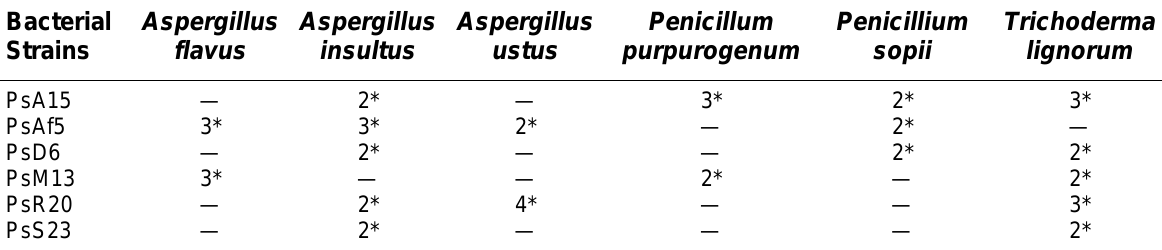
Antagonistic Activity of Pseudomonas spp. Against Nonpathogenic Fungi